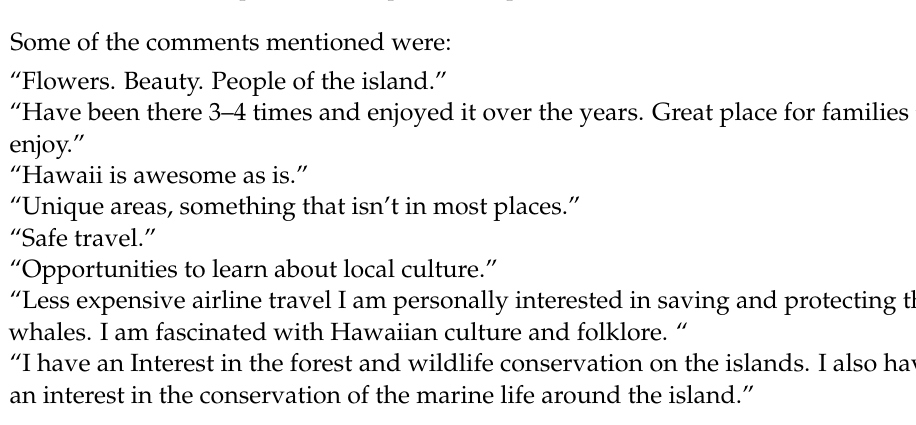
Figure 10. Word cloud of responses to the open-ended question.